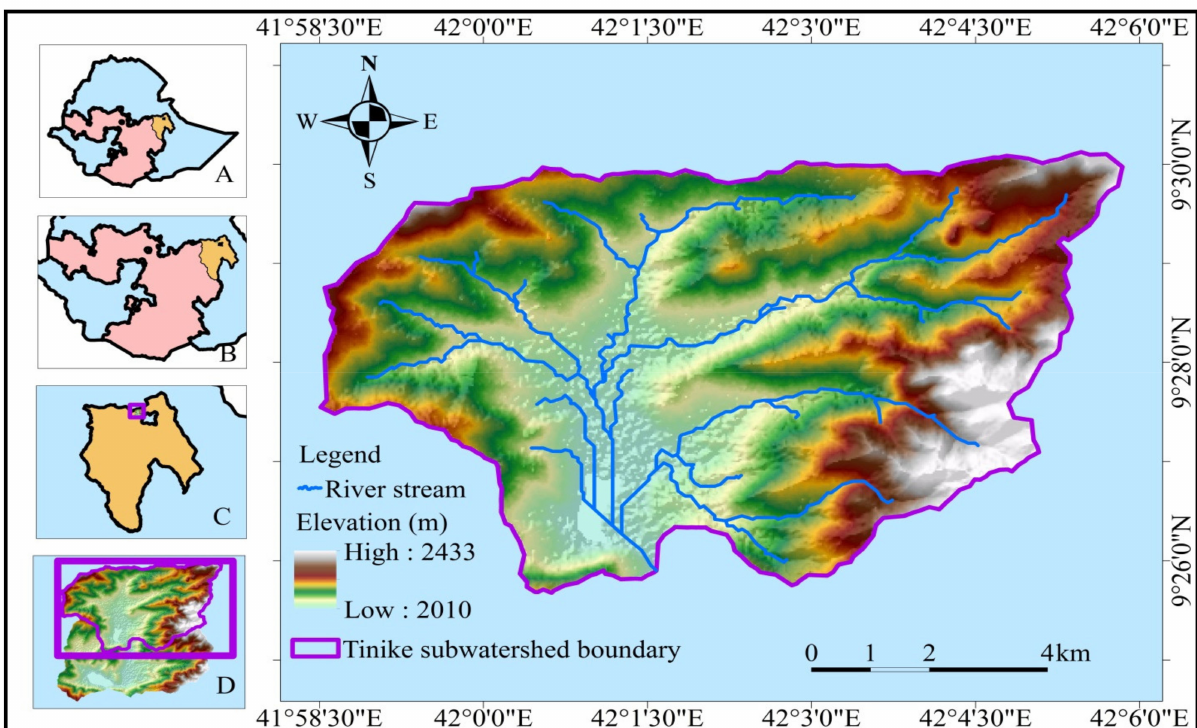
Figure 1. Map of a watershed using satellite image: ( A ) Ethiopia, ( B ) Oromia Region, ( C ) East Hararghe Zone and ( D ) Lake Haramaya